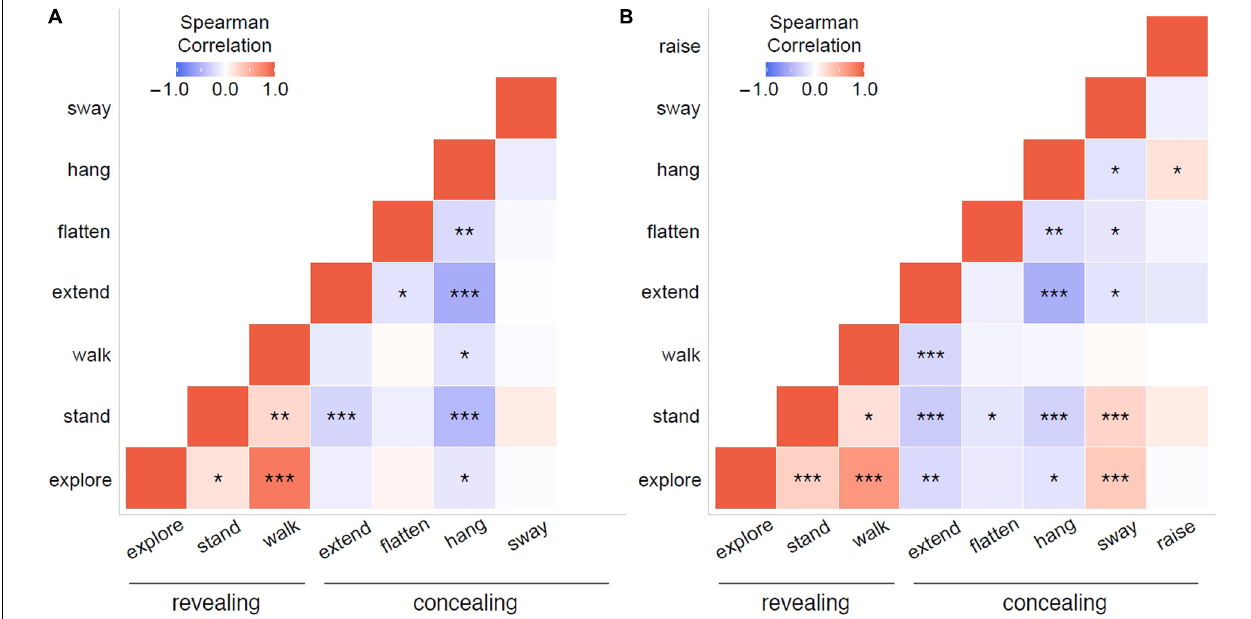
FIGURE 5 | Heat maps with pairwise correlations between the proportions of time spent on behaviors that significantly contributed to the distribution pattern during NMDS, for (A) the control treatment and (B) the wind treatment, integrated for all individuals in a treatment. Explore , stand , and walk are potentially revealing behaviors, while extend , flatten , hang , and sway are potentially concealing behaviors. Note that in the control treatment, raise was never observed. Colors and shading of the squares indicate the direction and strength of Spearman correlations, respectively. Asterisks indicate significance levels: *** p < 0.001; ** p < 0.01; * p < 0.05; fields without asterisks are not statistically